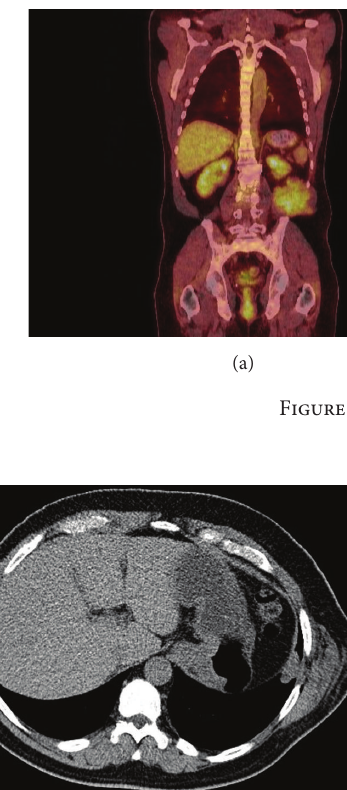
chordoma involving right posterior L2 elements with large right anterolateral epidural tumor extensions at L2 and L3 level has further progressed, now causing severe compromise of the thecal sac at L2-3 level. There was also interval increase in the size of the left retroperitoneal lymphadenopathy and the large left flank soft tissue metastasis. Tumor extension was also noted within the L2-L3 and L3-L4 neural foramina and right psoas muscle. There was no evidence of obvious intrathecal extension (Figures 1(a) and